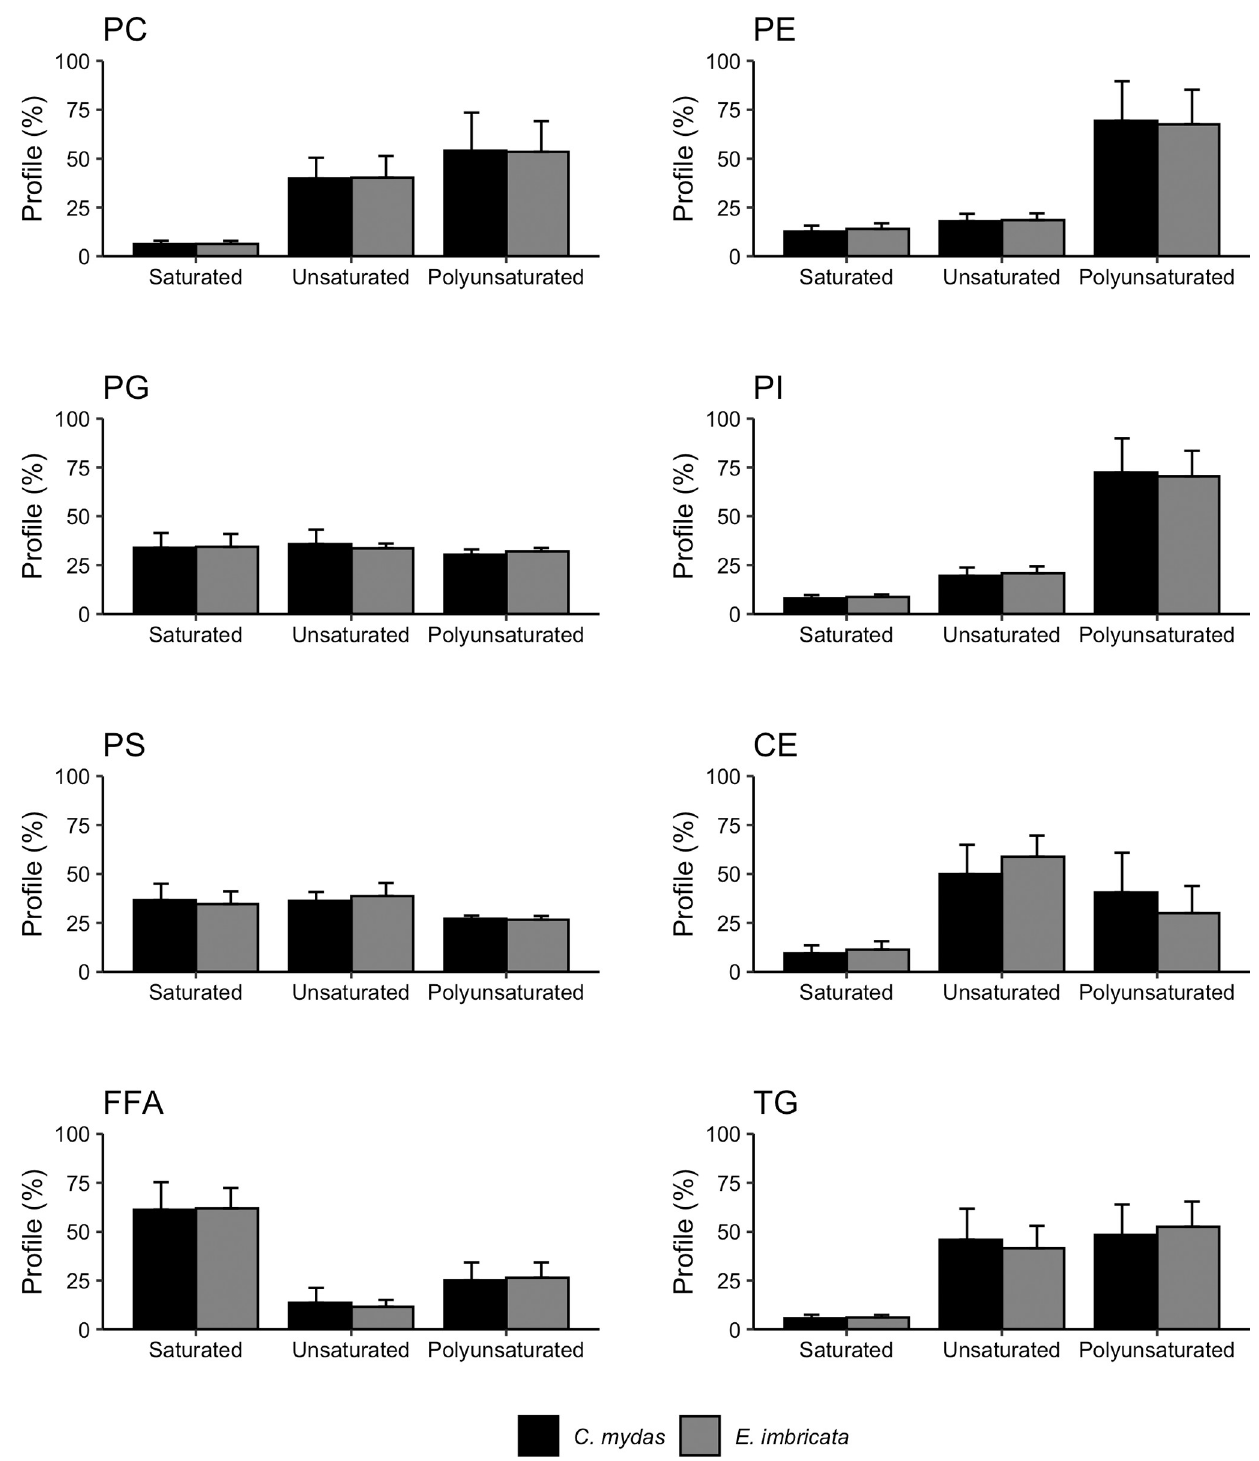
Fig 2. Percent lipid class profile from sea turtles divided by saturation and species. Bars and error bars represent mean ± standard deviation (%). The x- axis represents saturation level where saturated indicates lipids 0 double bonds, unsaturated indicates lipids with 1 or 2 double bonds, and polyunsaturated indicates lipids with � 3 double bonds. We did not include sphingomyelin, acyl-carnitine, or ceramide classes due to structure.